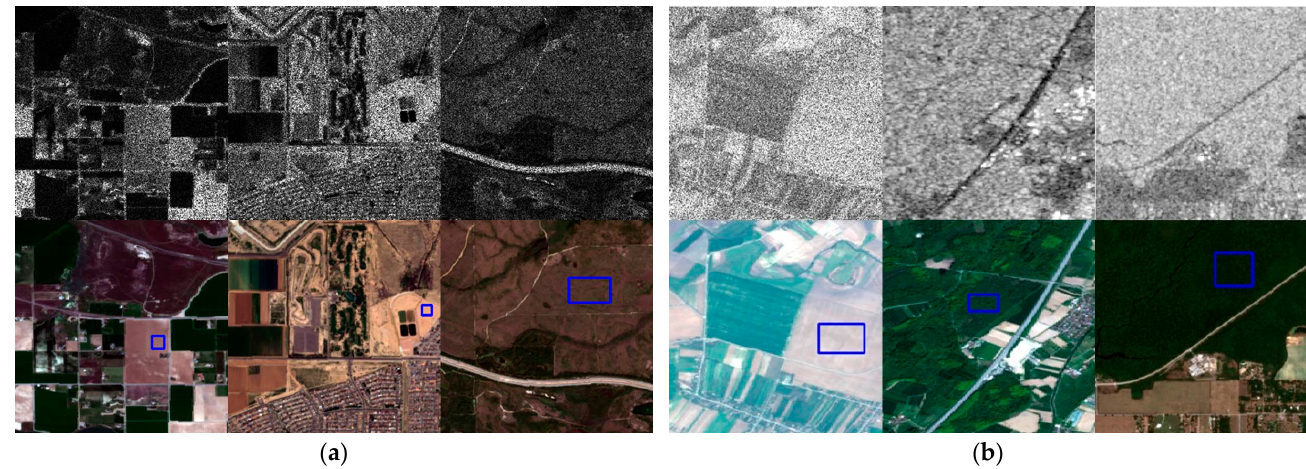
Figure 4. ( a ) Test synthetic multiplicative noise images (top line, from left to right: S1, S2, and S3, L = 1); ( b ) Test real-world SAR images (top line, from left to right: RS1, RS2, and RS3). Bottom line, from left to right, are the corresponding co-registered optical images. The blue boxes highlight the regions of interest being used to compute the Equivalent Number of Looks (ENL).